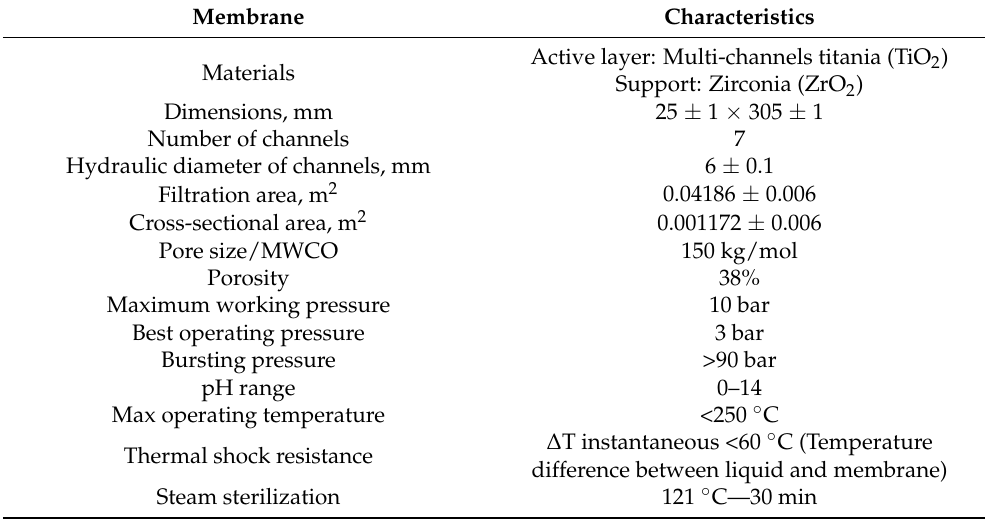
Figure 1. Ceramic membrane picture used in the experiment: ( a ) the entire illustration and cross- sectional area, ( b ) ceramic membrane internal channels and walls. Table 4. Ceramic membrane characteristics.